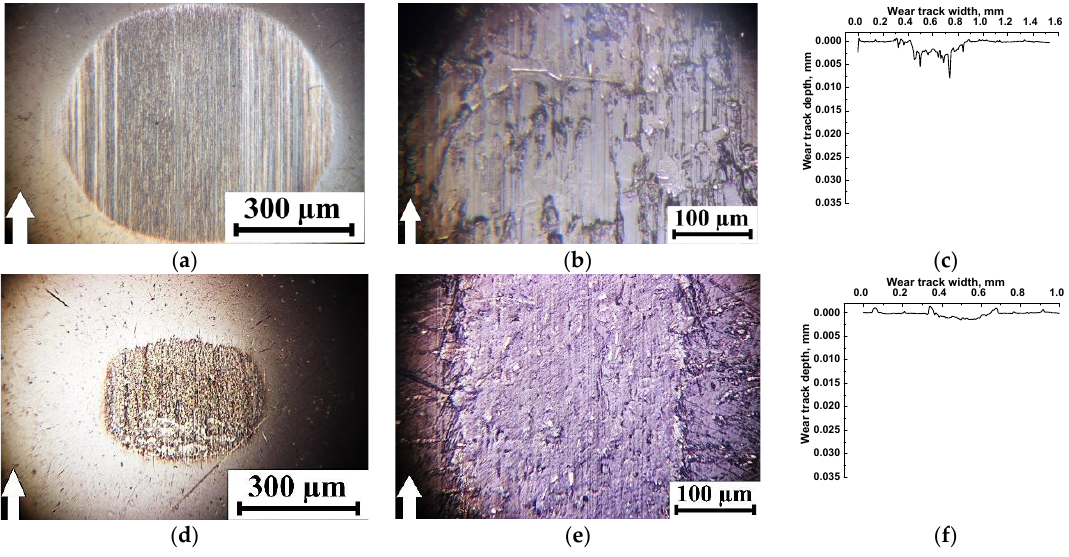
Figure 5. Optical photographs of the steel counterpart surfaces ( a , d ), wear tracks ( b , e ) and wear track profiles ( c , f ) after the tribological tests of the PEI/10CCF/1CNT ( a – c ) and PEI/10CCF/1HNT ( d – f ) nanocomposites. Point tribological contact. White arrows denote sliding direction.